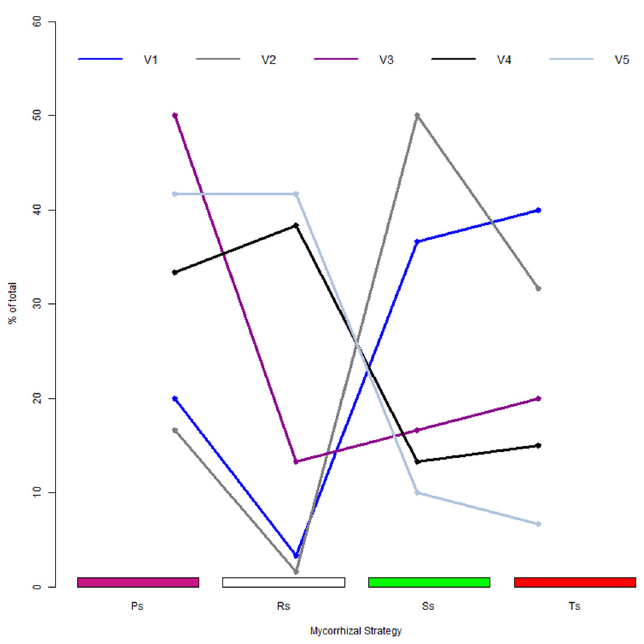
Figure 4. Variations in colonization strategies orientation due to the application of long-term treat- ments. Legend: Ps—proliferative strategy; Rs—resistance conditions strategy; Ss—storage strategy; Ts—transfer strategy. V1 (control variant)—untreated; V2—organic (manure) treatment—10 t ha − 1 manure; V3—low-mineral organic treatment—10 t ha − 1 manure + 50 N 25 P 2 O 5 25 K 2 O; V4—mineral treatment—100 N 50 P 2 O 5 50 K 2 O; V5—high-mineral organic treatment—10 t ha − 1 manure + 100 N 50 P 2 O 5 50 K 2